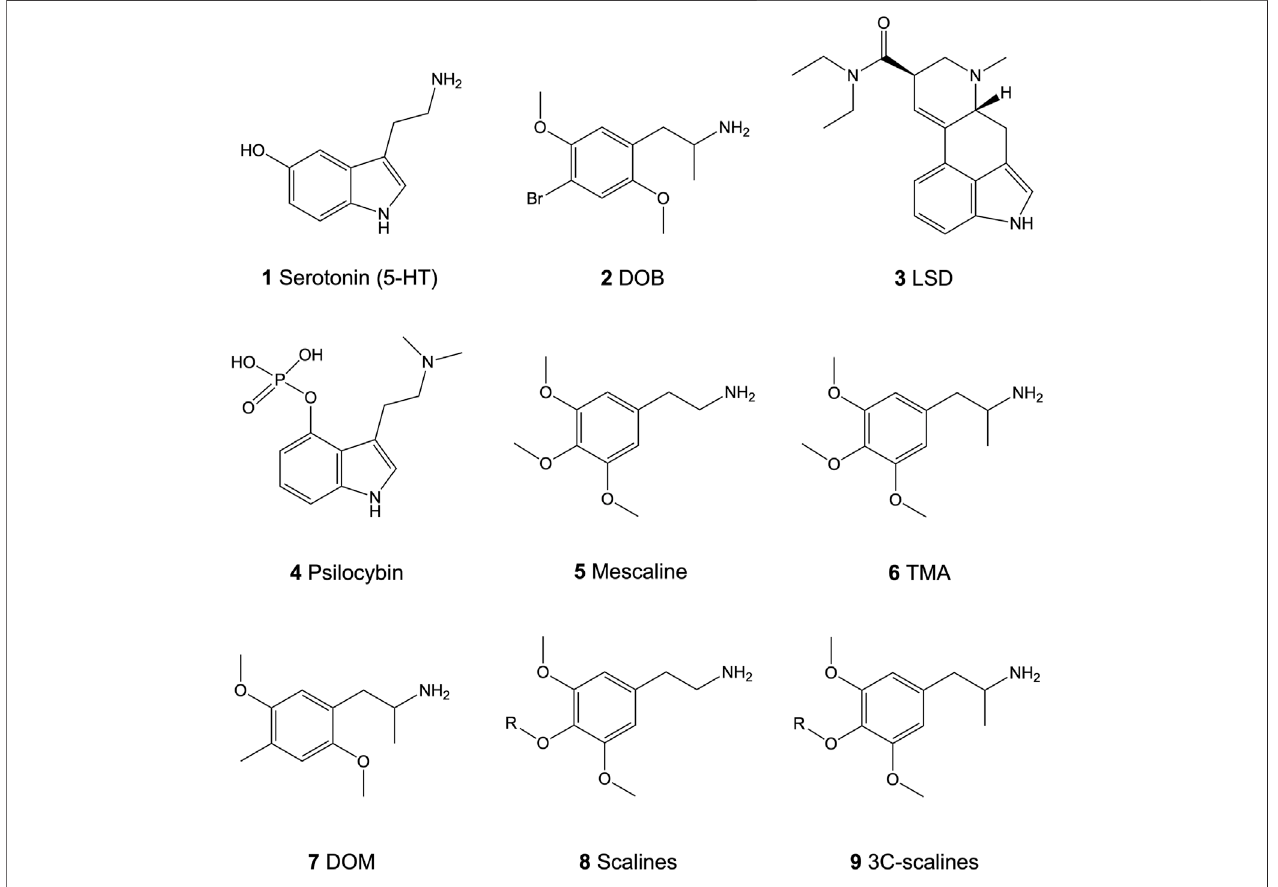
FIGURE 1 | Chemical structures of the neurotransmitter serotonin (5-HT; 1 ) and the psychedelics 4-bromo-2,5-dimethoxyamphetamine (DOB; 2 ), lysergic acid diethylamide (LSD; 3 ), psilocybin ( 4 ), 3,4,5-trimethoxyphenethylamine (mescaline; 5 ), 3,4,5-trimethoxyamphetamine (TMA; 6 ), and 2,5-dimethoxy-4-methyl- amphetamine (DOM; 7 ), and the core structure of the 4-alkoxy-3,5-dimethoxyphenethylamines (scalines; 8 ) and 4-alkoxy-3,5-dimethoxyamphetamine (3C-scalines; 9 ).